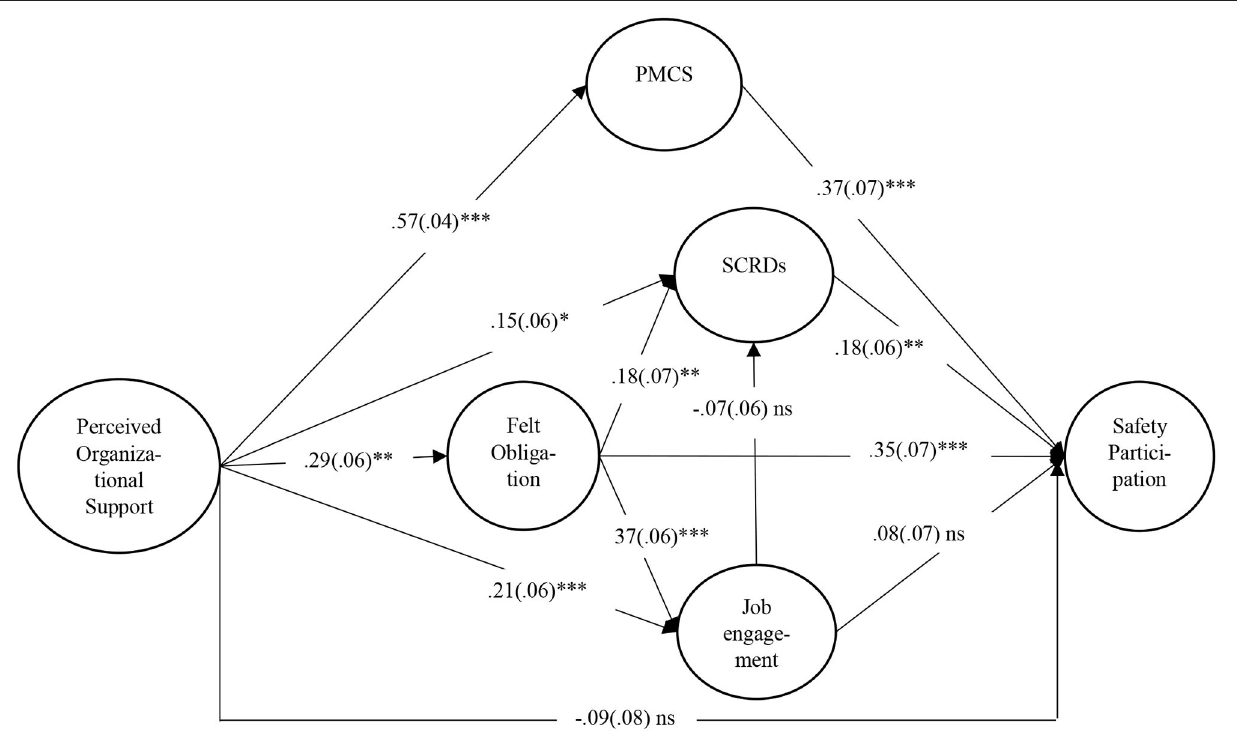
FIGURE 2 | Final model. N = 536. Standardized coefficient paths. * p < 0.05, ** p < 0.01, *** p < 0.001. Standard error within parentheses. PMCS, perceived management commitment to safety; SCRDs, safety citizenship role